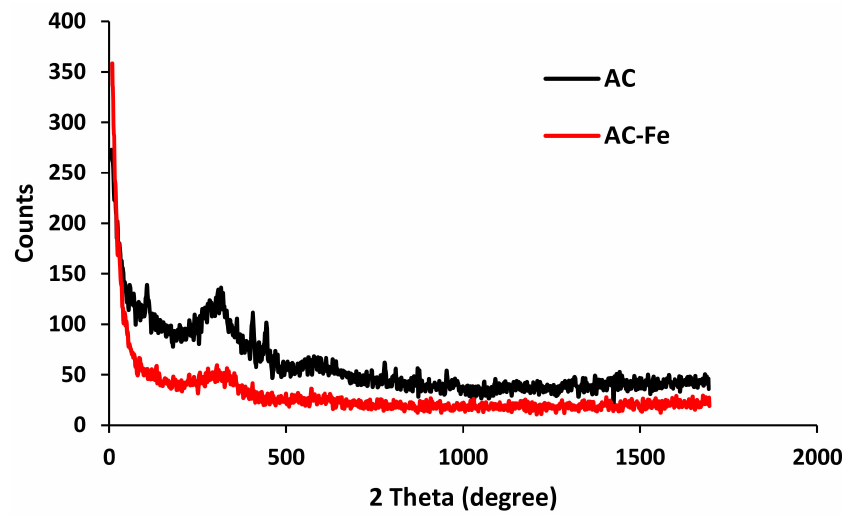
Figure 1. Comparative X-ray diffractograms of AC and AC-Fe.